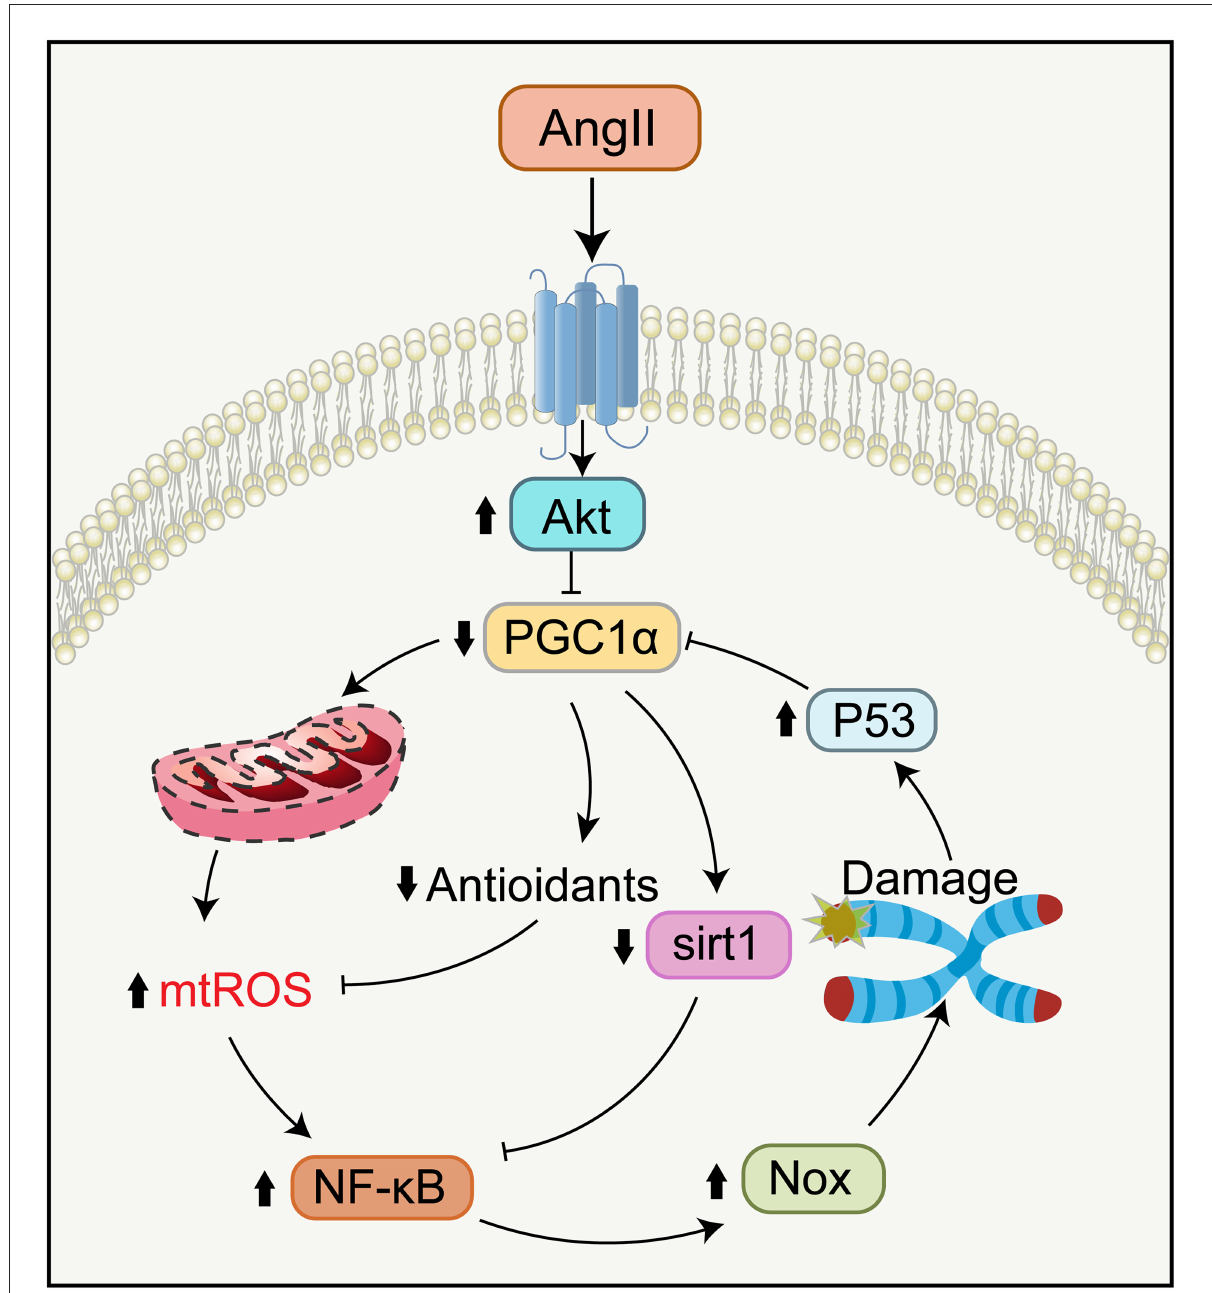
FIGURE5 Signaling pathways in telomere attrition and mitochondrial dysfunction during aging. Ang II binding to AT 1 R reduces the function of PGC-1 α via activating Akt, causing the compromises of Sirt1 activity and oxidative defense. Telomere attrition mediates mitochondrial impairment by the p53-dependent downregulation of PGC-1 α . Impaired mitochondria generate more mtROS which leads to further telomere attrition and replicative senescence by NF- κ B-dependent upregulation of Nox. NF- κ B, nuclear factor κ